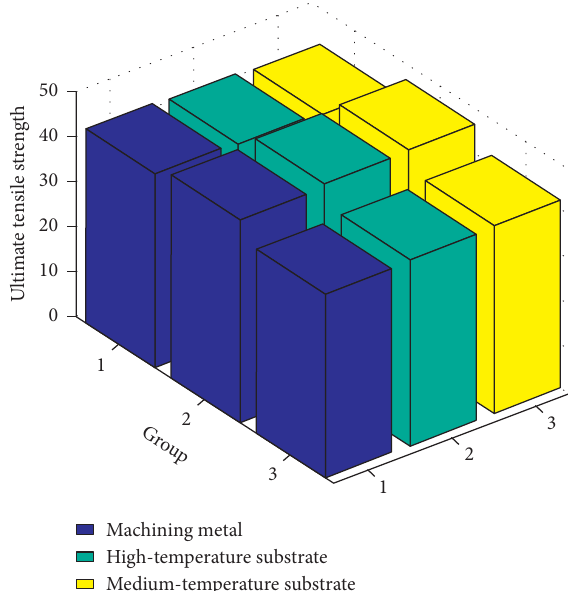
Figure 4: Ultimate tensile strength of tensile specimens.